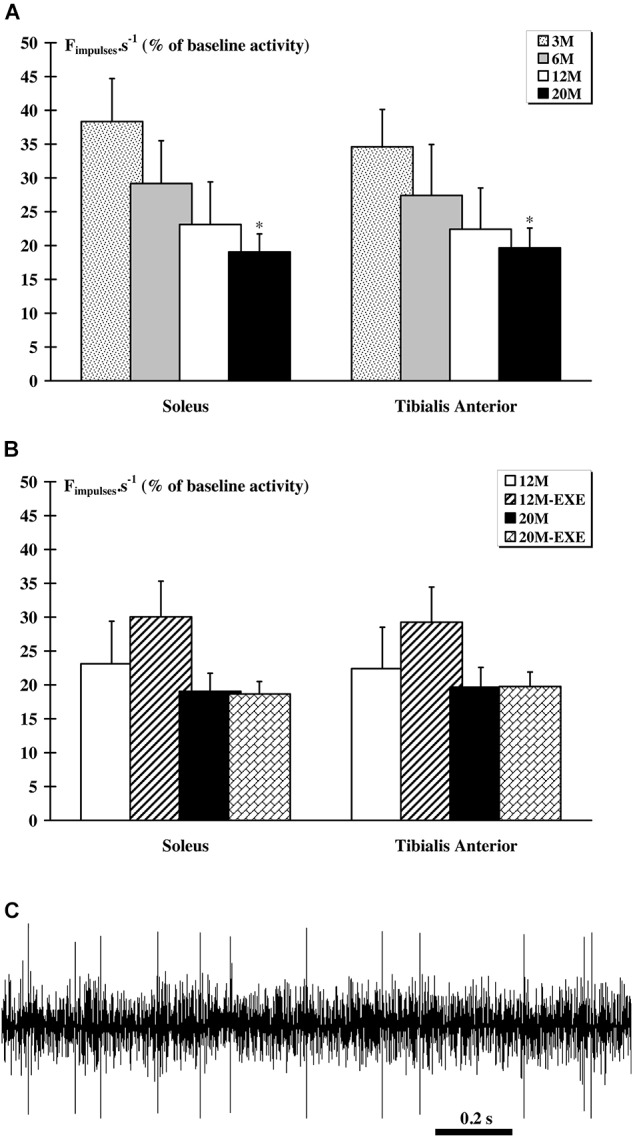
Comparison of the response of metabosensitive afferents fibers to muscle electrically-induced fatigue (EIF) between non-active and active aged rats. In all groups, a significant (p < 0.05) increase in activity was recorded after 3-min EIF. (A) In sedentary groups, the magnitude of the response to EIF decrease with age and was significantly (p < 0.05) lower in the 20 M group compared to the 3 M group whatever the muscle considered. (B) In the older animals, whatever the muscle considered and despite an increasing tendency for 12M-EXE group, no difference was noted. (C). Example of extracellular recording of afferent fibers from tibialis anterior muscle in 12 M-EXE group.